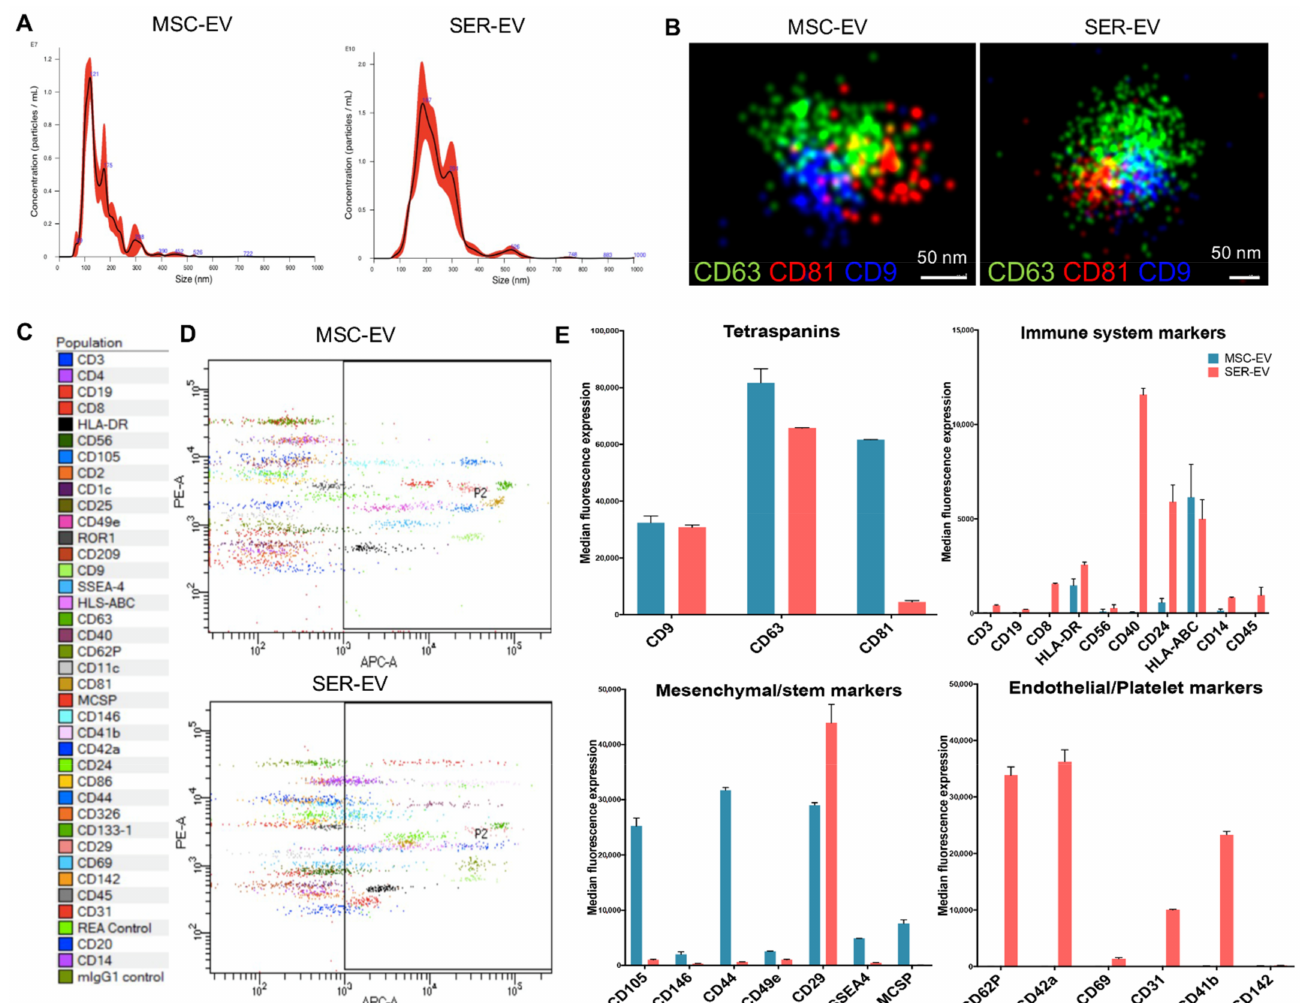
Figure 2. Characterization of mesenchymal stem cell-derived extracellular vesicles (MSC-EVs) and blood serum-derived EVs (SER-EVs). ( A ) Representative nanoparticle tracking analysis showing the EV size distribution. ( B ) Super resolution microscopy micrographs showing the pattern distribution of CD63 in green, CD81 in red, and CD9 in blue for one MSC-EV and SER-EV. Scale bar: 50 nm. ( C ) Legend showing the 39 antibodies used in the assay and their respective colors in the dot plots. ( D ) MACSPlex representative dot plots showing the MSC-EV and SER-EV distribution of allophycocyanin (APC)-stained bead populations; captured EVs are counterstained with APC-labeled detection antibodies using a mixture of anti-CD9, anti-CD63, and anti-CD81 (pan tetraspanins) antibodies. ( E ) Representative quantification of the median APC fluorescence positive values for the bead populations after background correction, clustered in different graphs according to their classification: tetraspanins, immunological, mesenchymal, and endothelial